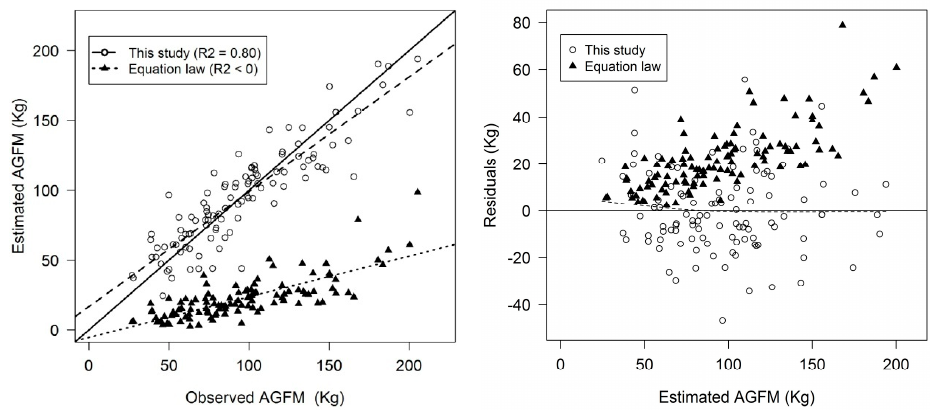
Figure 6. ( Left ) Comparison between above-ground fresh mass (AGFM) equation developed in this study and law-based equation currently recommended by estimated and observed plot and; ( Right ) Residuals distribution of the two allometric equations for AGFM estimation.